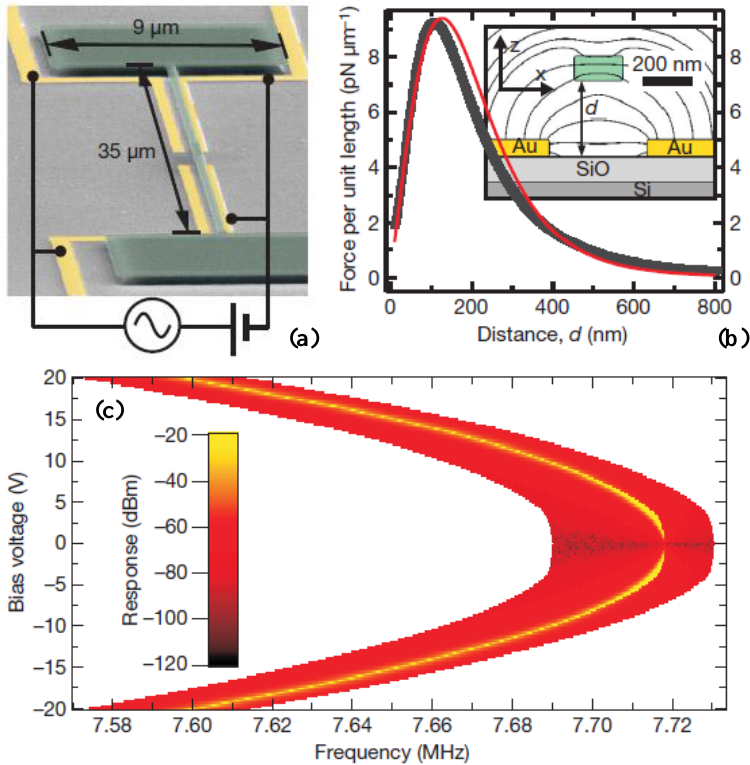
Figure 28. ( a ) SEM of a nanomechanical resonator reported by Unterreithmeier et al . [34]; ( b ) The dielectric force acting on the resonator; ( c ) Frequency tuning of the resonator. Reused with permission from [34], Copyright 2009, Nature Publishing